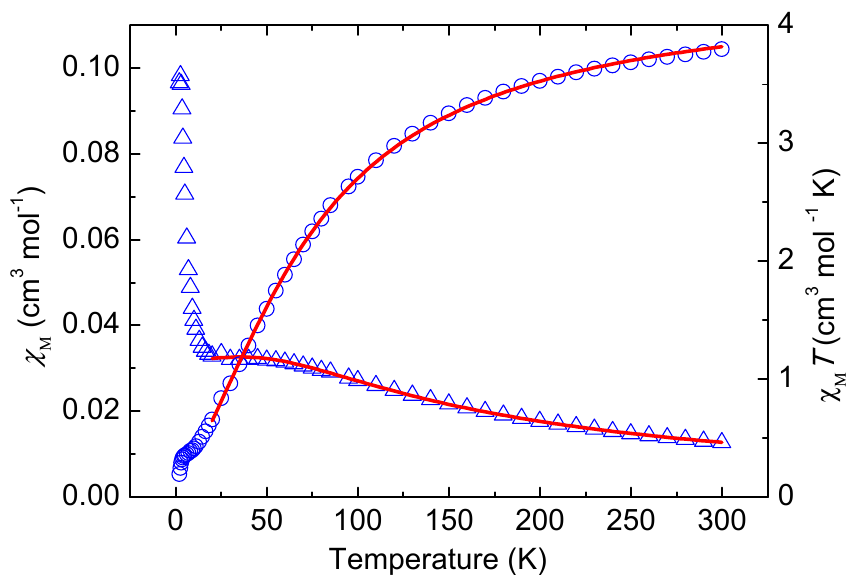
Figure 4. The temperature dependences of χ M (triangles) and χ M T(circles) of compound 1 . The solid line represents the best fit given in the text.